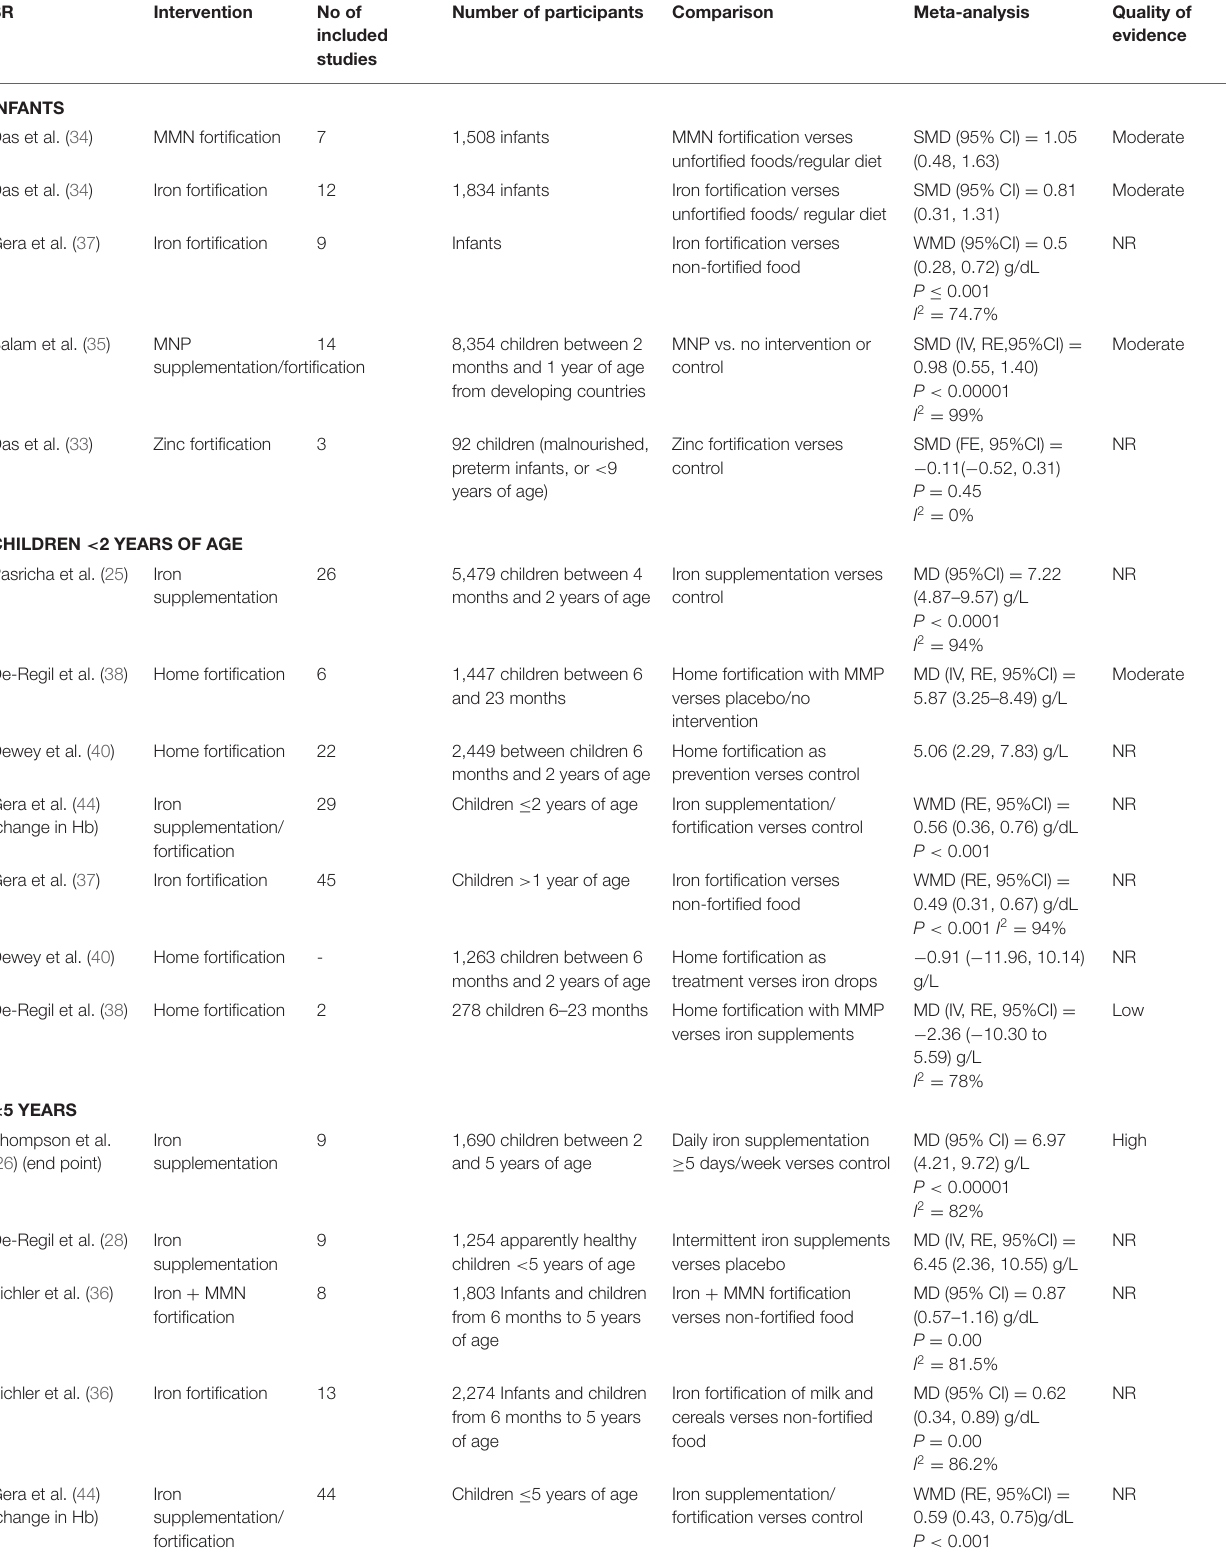
TABLE 3 | Findings for hemoglobin in included systematic reviews. SR Intervention No of Number of participants Comparison Meta-analysis Quality of included studies